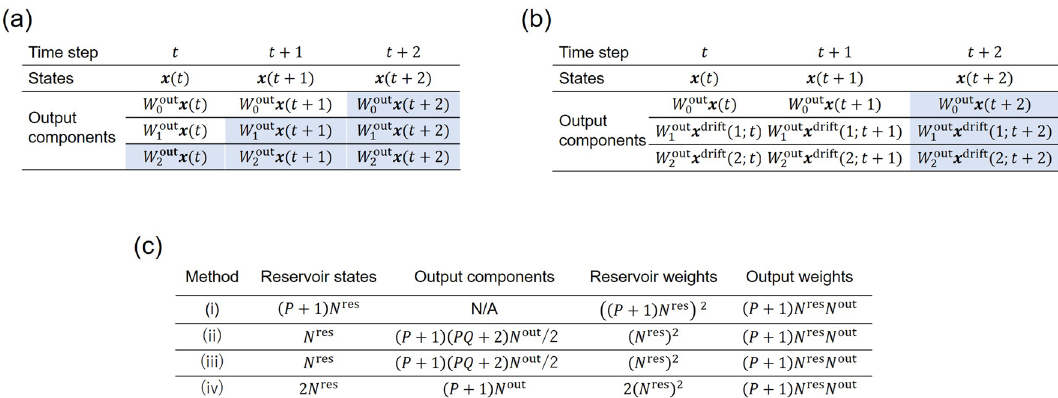
Figure 3. Memory requirements. ( a ) Memory requirement for delay-state concatenation when P is two and Q is one. Output components that are stored in memory at time step t + 2 for computing outputs at this time step or future time steps are masked with blue color. ( b ) Memory requirement for drift-state concatenation when P is two. Output components that are stored in memory at time step t + 2 for computing outputs at this time step are masked with blue color. ( c ) Comparison of memory requirement for (i) standard RC 8 , (ii) delay-state concatenation, (iii) delay-state concatenation with transient states, and (iv) drift-state concatenation. Values in each column represent the amounts of memory required to store vectors. The effective dimension of RC is ( P + 1 ) N res for all the